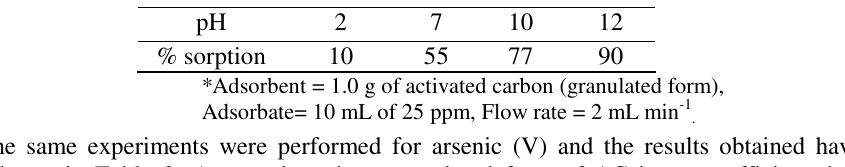
Table 2 Influence of pH on the adsorption of arsenic (V) on to AC pH 3 7 10 % Sorption (GAC)* 60 55 40 % Sorption (PAC) 75 70 60 *All conditions were the same as used for As(III) in Table 1. GAC= Granulated Activated carbon, and PAC= powdered Activated